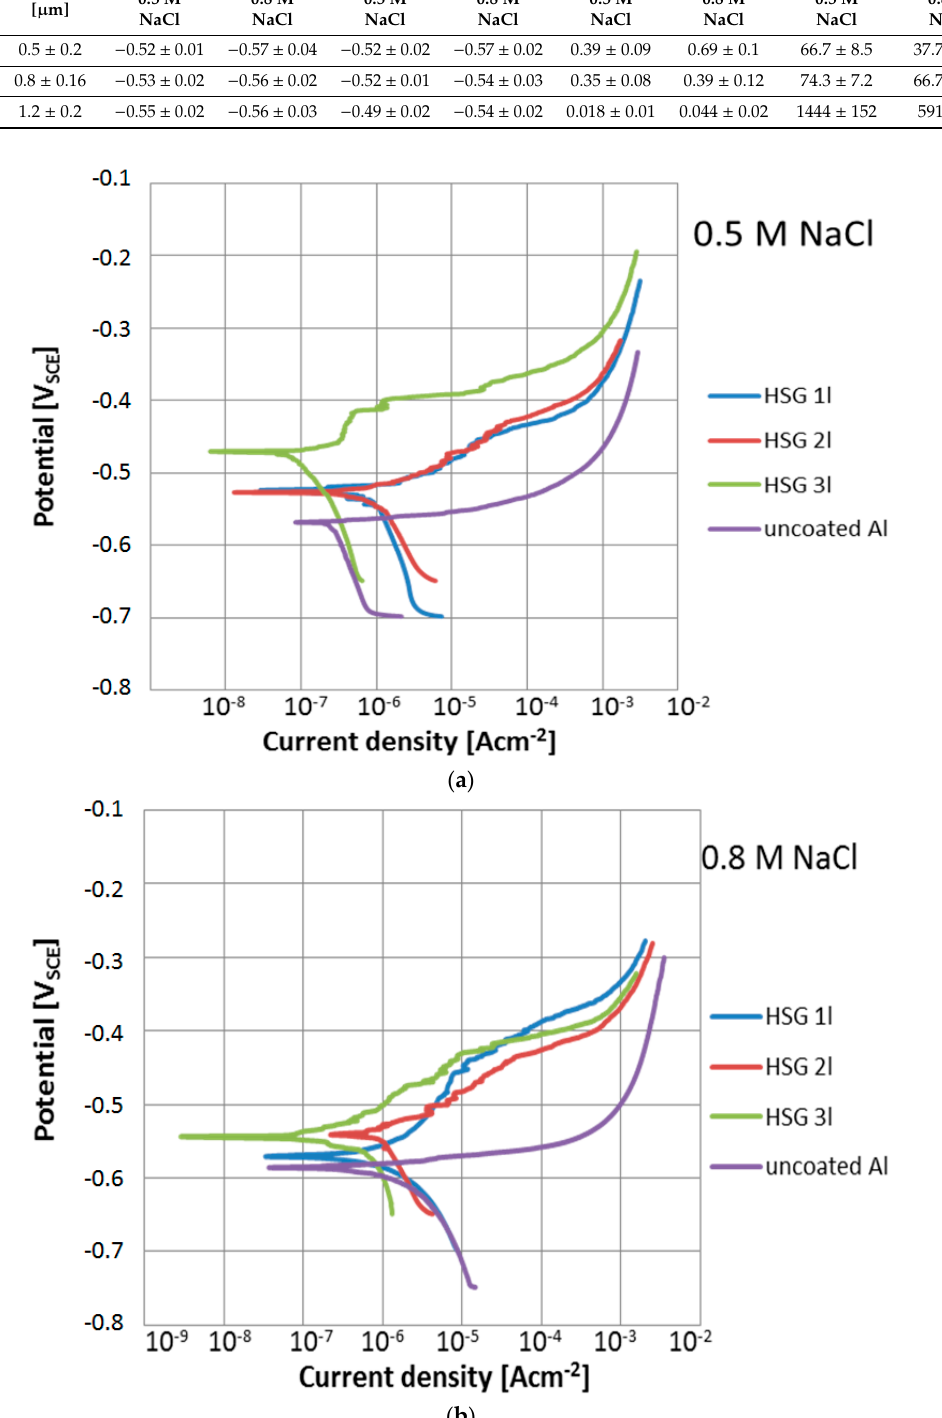
Figure 3. Potentiodynamic curves of uncoated and coated aluminum alloy in a ) 0.5 M NaCl and b ) 0.8 M NaCl. ( b ) 0.8 M